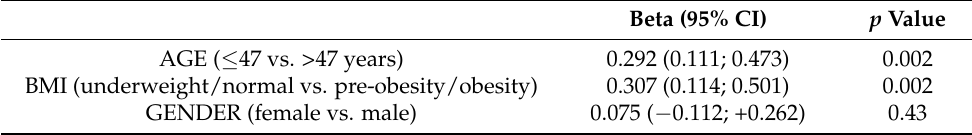
Table 2. Multivariate linear regression of AU/mL by age, BMI and